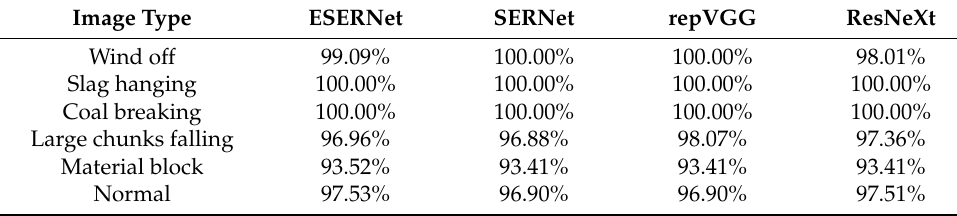
Table 3. Classification Accuracy of Blast Furnace Tuyere Images by Different Models.